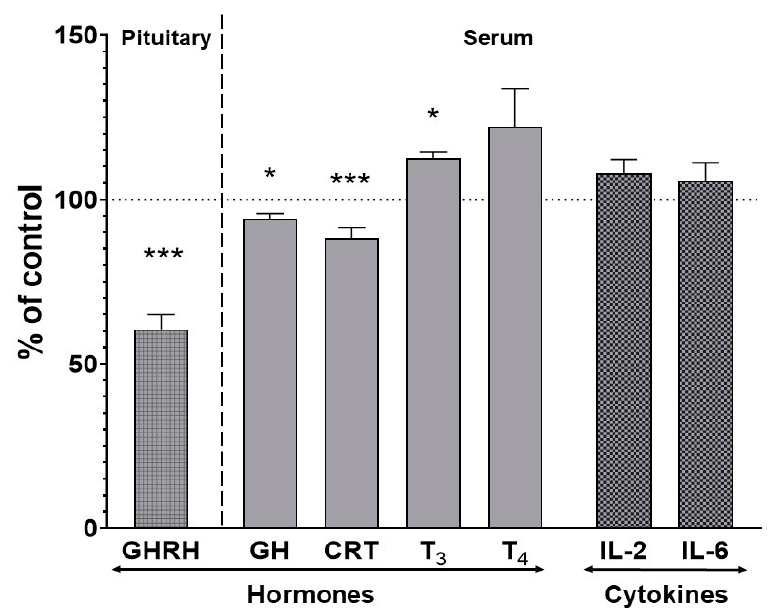
Figure 4. The effect of chronic asenapine treatment on the levels of pituitary and serum hormones and serum cytokine concentrations. All the values are the mean ± S.E.M. of the control ( n = 12) and asenapine treatment ( n = 12) group. Statistical significance was assessed by Student’s t -test and shown as * p < 0.05 or *** p < 0.001 compared to the control. The absolute control values were: 38.09 ± 4.47 ng/mg for pituitary growth hormone-releasing hormone (GHRH); 5.5 ± 0.31 ng/mL, 16.46 ± 1.62 ng/mL, 1.27 ± 0.094 ng/mL, 3.2 ± 0.97 ng/mL, 60.15 ± 8.43 ng/mL and 1.0 ± 0.18 ng/mL for serum growth hormone (GH), corticosterone (CRT), triiodothyronine (T 3 ), thyroxine (T 4 ), interleukin-2 (IL-2) and interleukin-6 (IL-6), respectively.